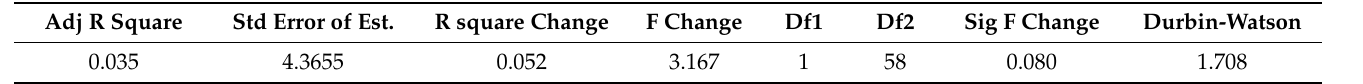
Table 5. Life expectancy.